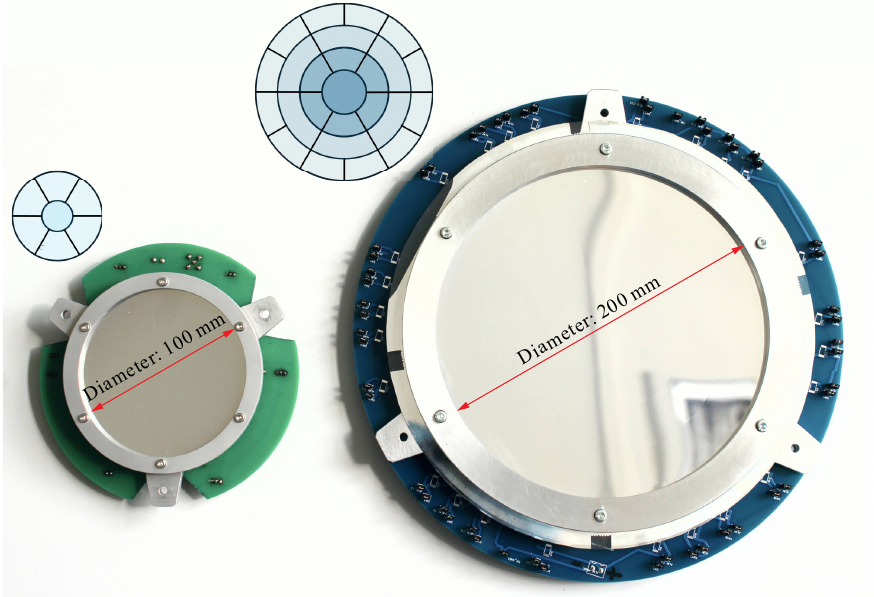
Figure 4. Demonstrators built and tested in the earlier part of the project: D = 100 mm with